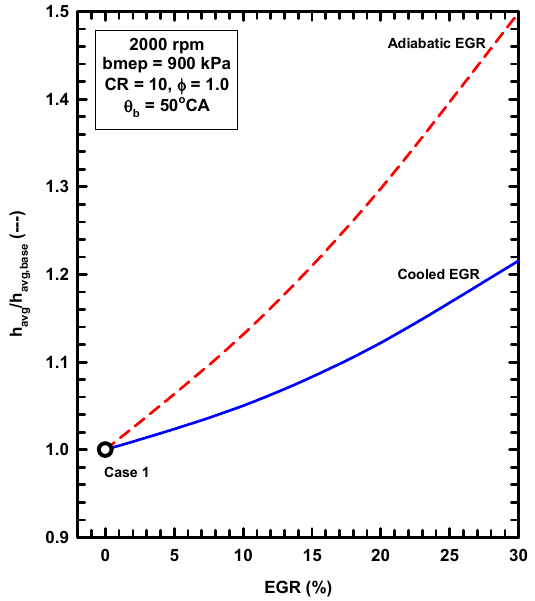
Figure 16. The ratio of the average heat transfer coefficient and the average heat transfer coefficient for case 1 as functions of the EGR percentage for the two EGR configurations.